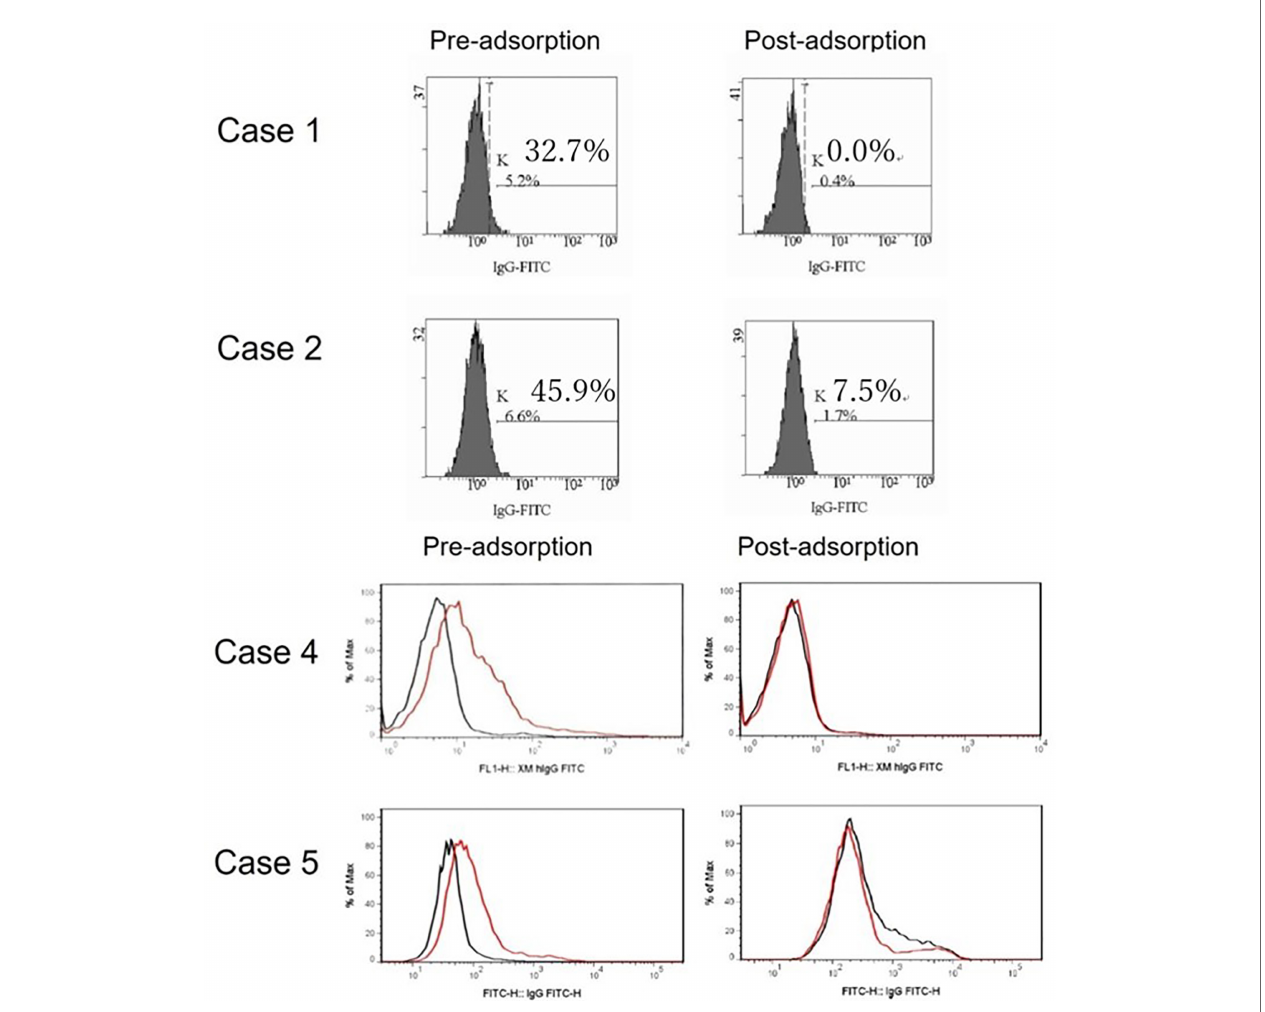
FIGURE 1 | FTXM results for kidney-transplant recipients obtained before and after preincubation with donor red blood cells (RBCs). Recipient sera were incubated with donor type B RBCs to adsorb anti-ABO antibodies prior to repeat FTXM; all results were then negative. In cases 1 and 2, the MCS values changed from 32.7% to 0.0% and 45.9% to 7.5%, respectively. In cases 4 and 5, the negative control IgG-FITC (minute XM IgG-FITC) values fell from 1.9 to 1.0 and 2.2 to 1.1 (cutoff 1.4),